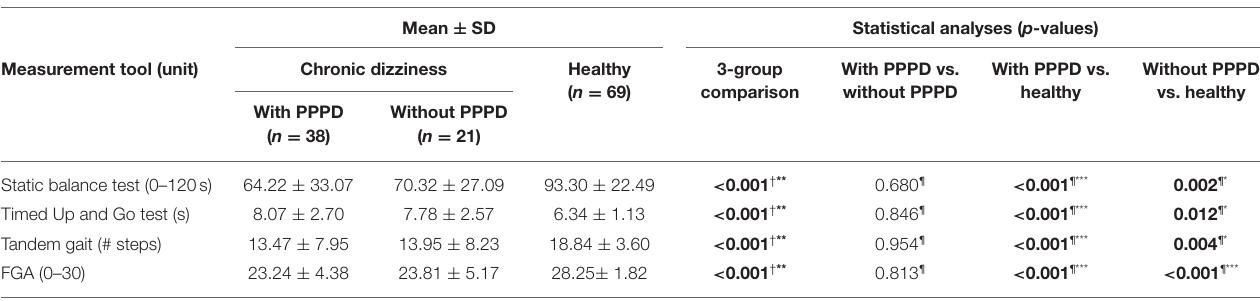
TABLE 3 | Results on clinical balance tests of the included participants a,b . Measurement tool (unit) Chronic dizziness Healthy